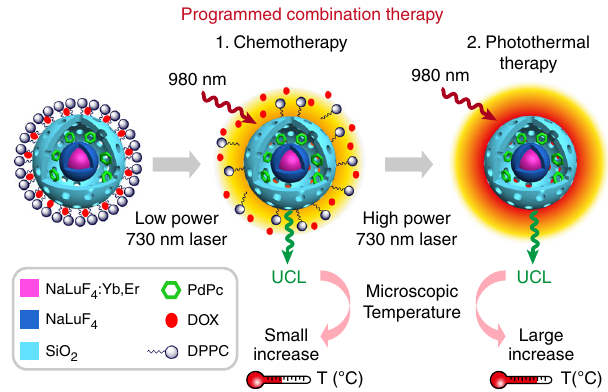
Fig. 1 Schematic diagram of programmed combination